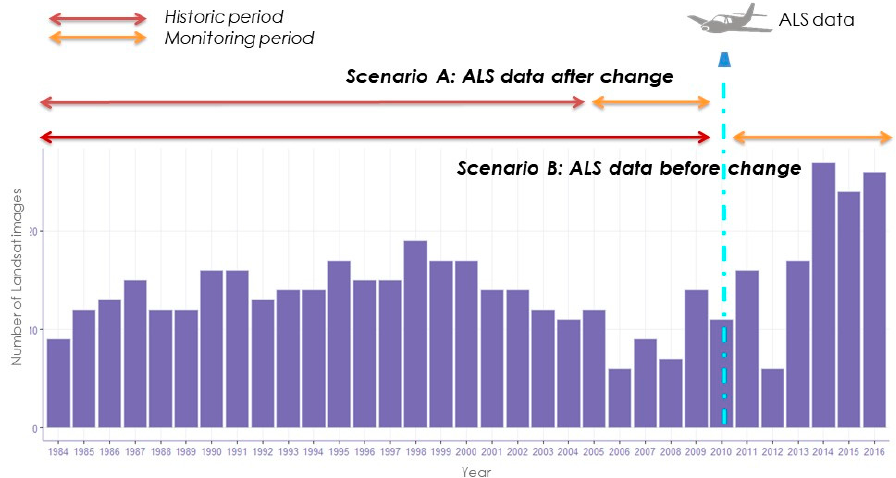
Figure 2. Number of scenes used per year analyzed with BFAST, and visualization of historic and monitoring periods. Two scenarios are considered to assess how ALS data may help characterizing change. In scenario A , ALS metrics are available at the end of the monitoring period ; in scenario B , ALS metrics are available at the beginning of the monitoring period .